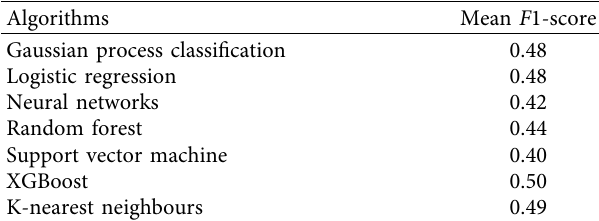
Table 3: Summary of mean F 1-score for audio features.